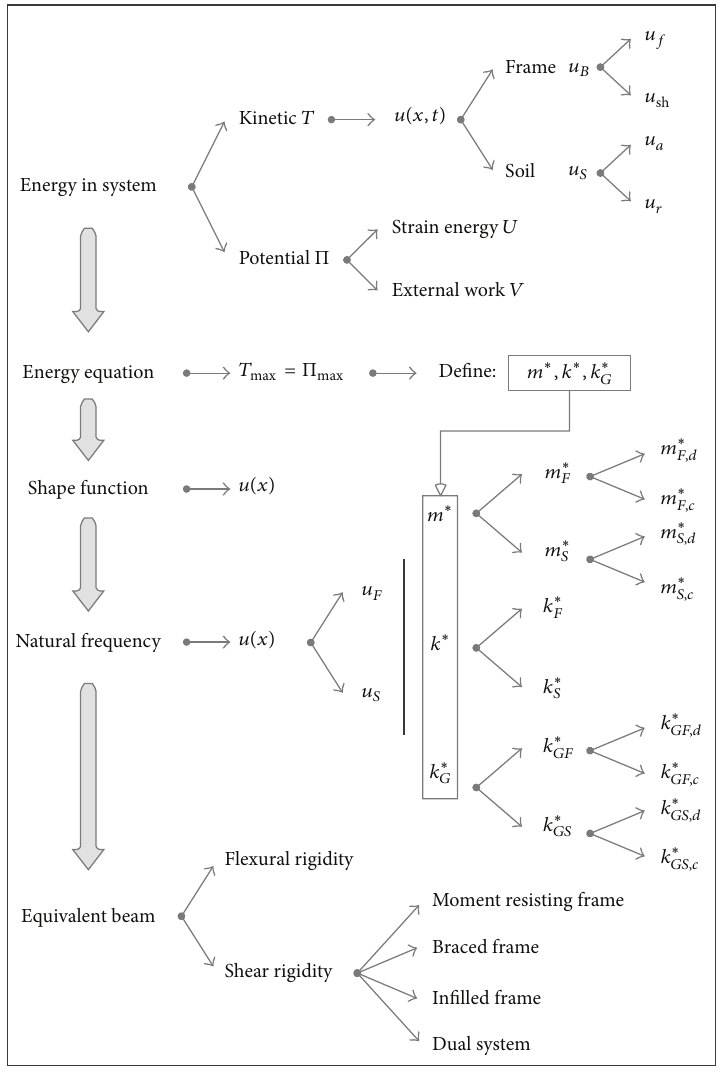
Figure 8: Proposed algorithm for analytical vibration analysis of the